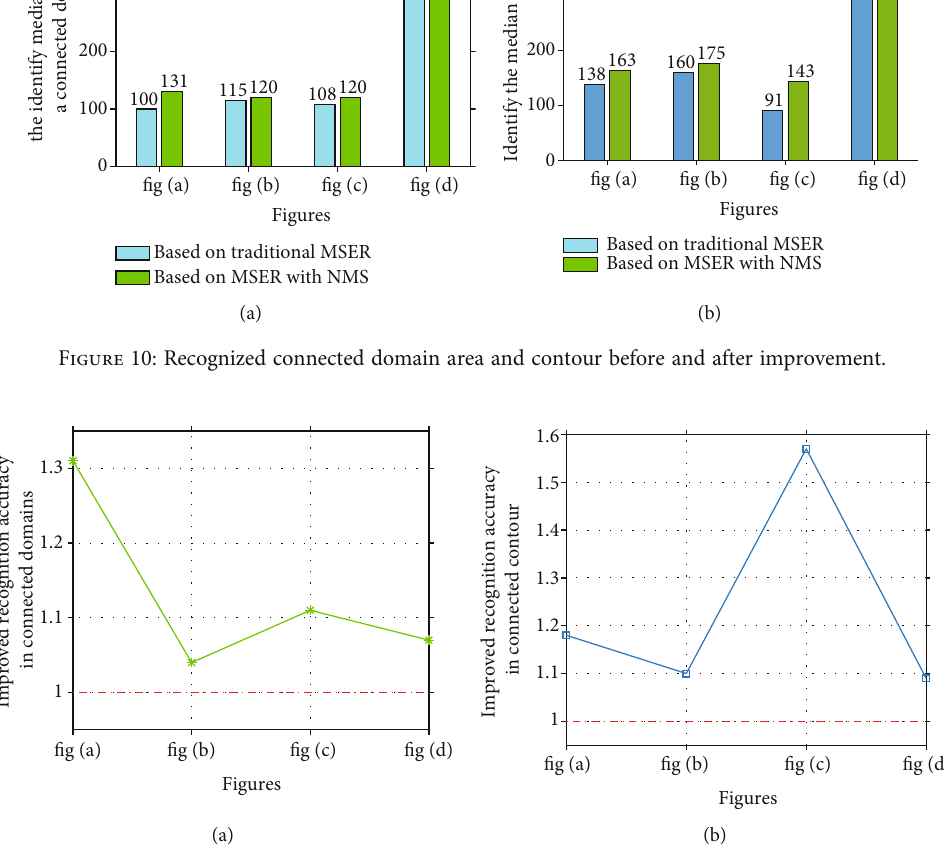
Figure 11: Analysis of recognition accuracy before and after